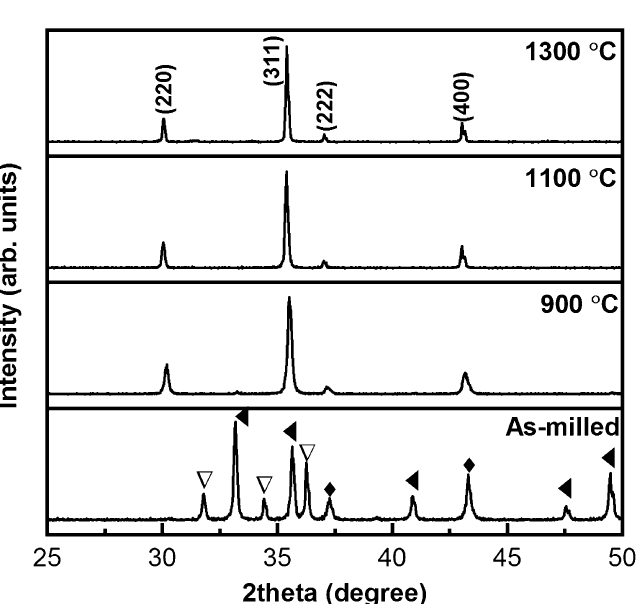
Figure 3. XRD patterns of the as-milled and calcined powders at 900 °C and the samples sintered at 1100 and 1300 °C ( ▽ : ZnO, ◆: NiO, and ◄ : Fe 2 O 3